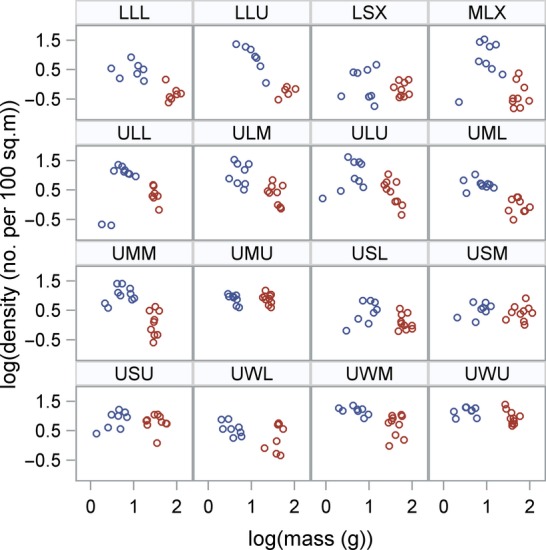
The relationship between average mass and density for subyearling (blue circles) and yearling (red circles) steelhead in 2010 and 2011 across the 16 study sites in the Lapwai Creek watershed, USA. The data are based on an average of five visits to each site each year and are shown on a logarithmic scale with base 10.